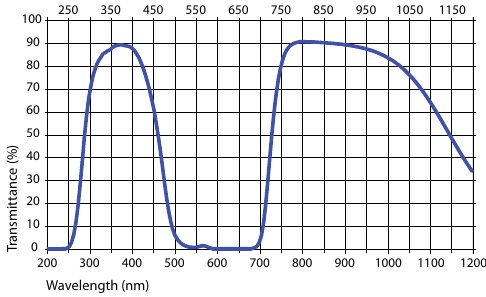
Figure 8. Transmittance of band-pass filter (adapted from: